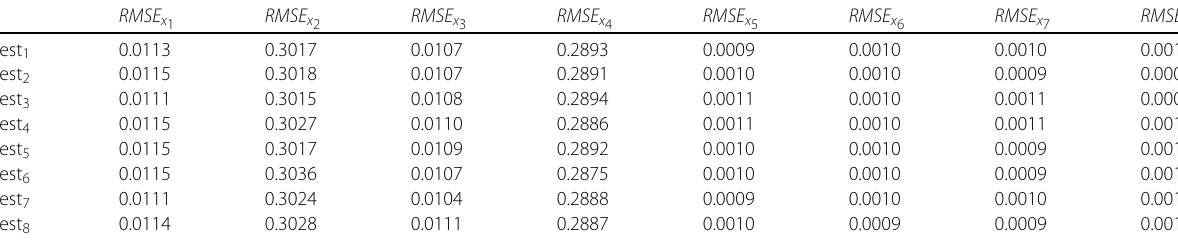
Table 3 RMSE × 10 –3 for the estimation performed by the H-infinity KF